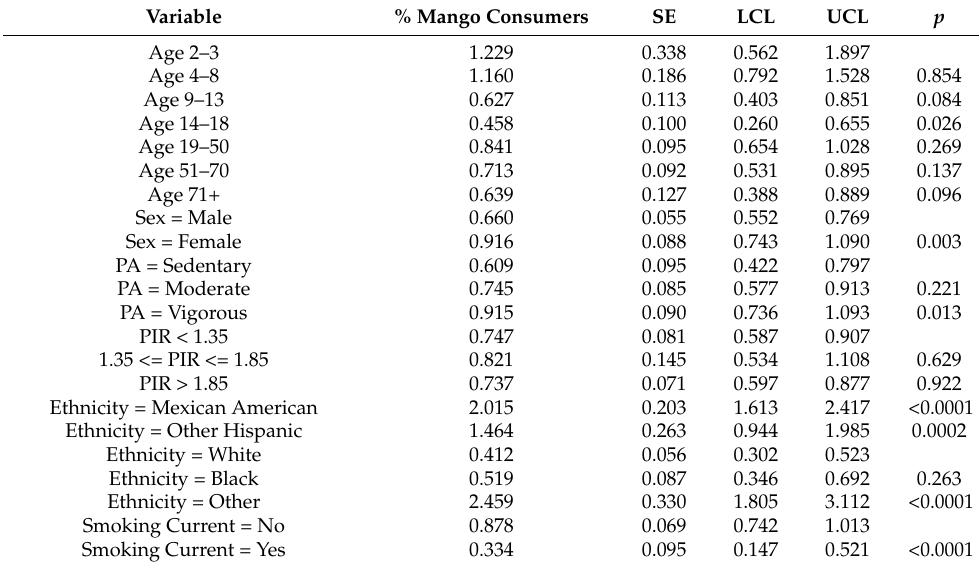
Table 1. Estimated percentage of mango consumers by levels of demographic variables.